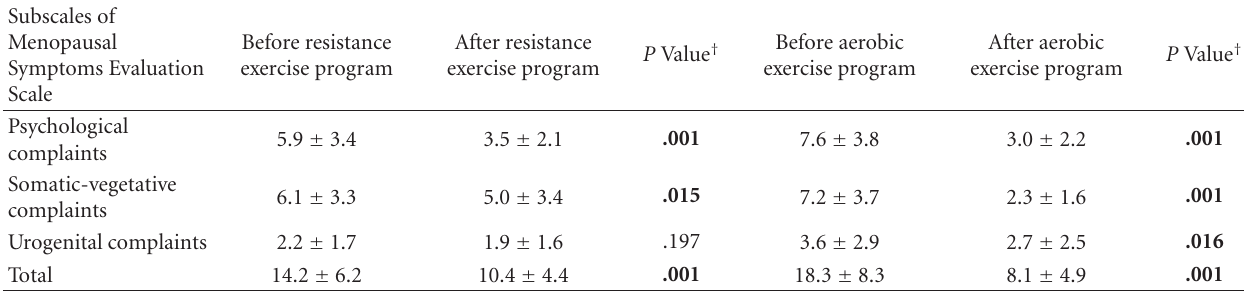
Table 3: MRS scale subscale points of cases in resistance group before and after the program X ± SD, N =